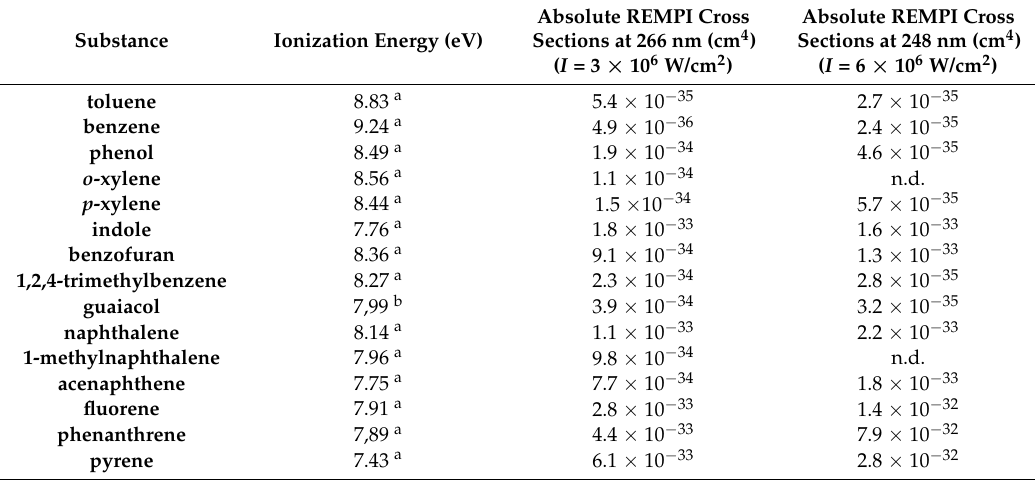
Table 2. Overview of absolute REMPI cross sections at 266 nm and 248